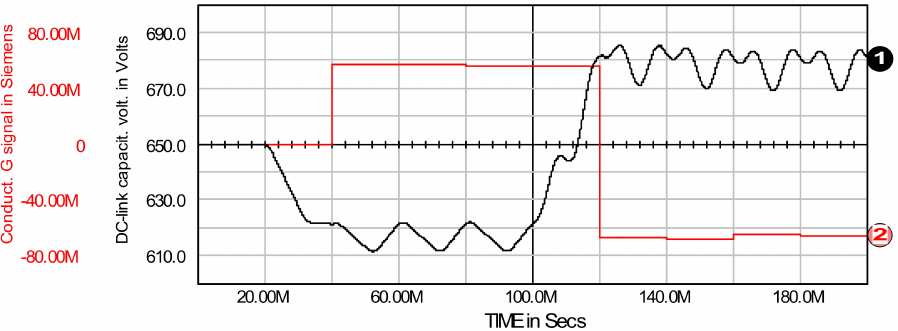
Figure 7. DC-link capacitor voltage: waveform 1, and conductance signal (22): waveform 4. The passive part of the load is switched on at t 1 = 20 ms, and the generative part is activated at t 2 = 100 ms. Based on Figure 7, some characteristic parameters of both signals can be